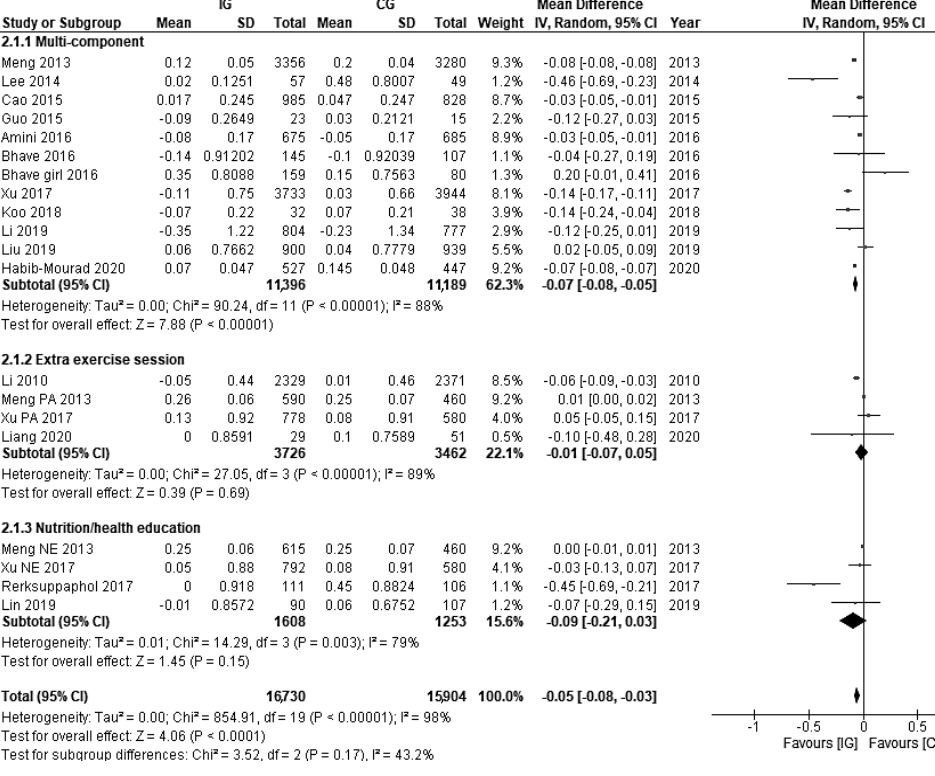
Figure 5. Pooled effects on BAZ and the differences between multi-component interventions, nutrition education and extra exercise prescription.